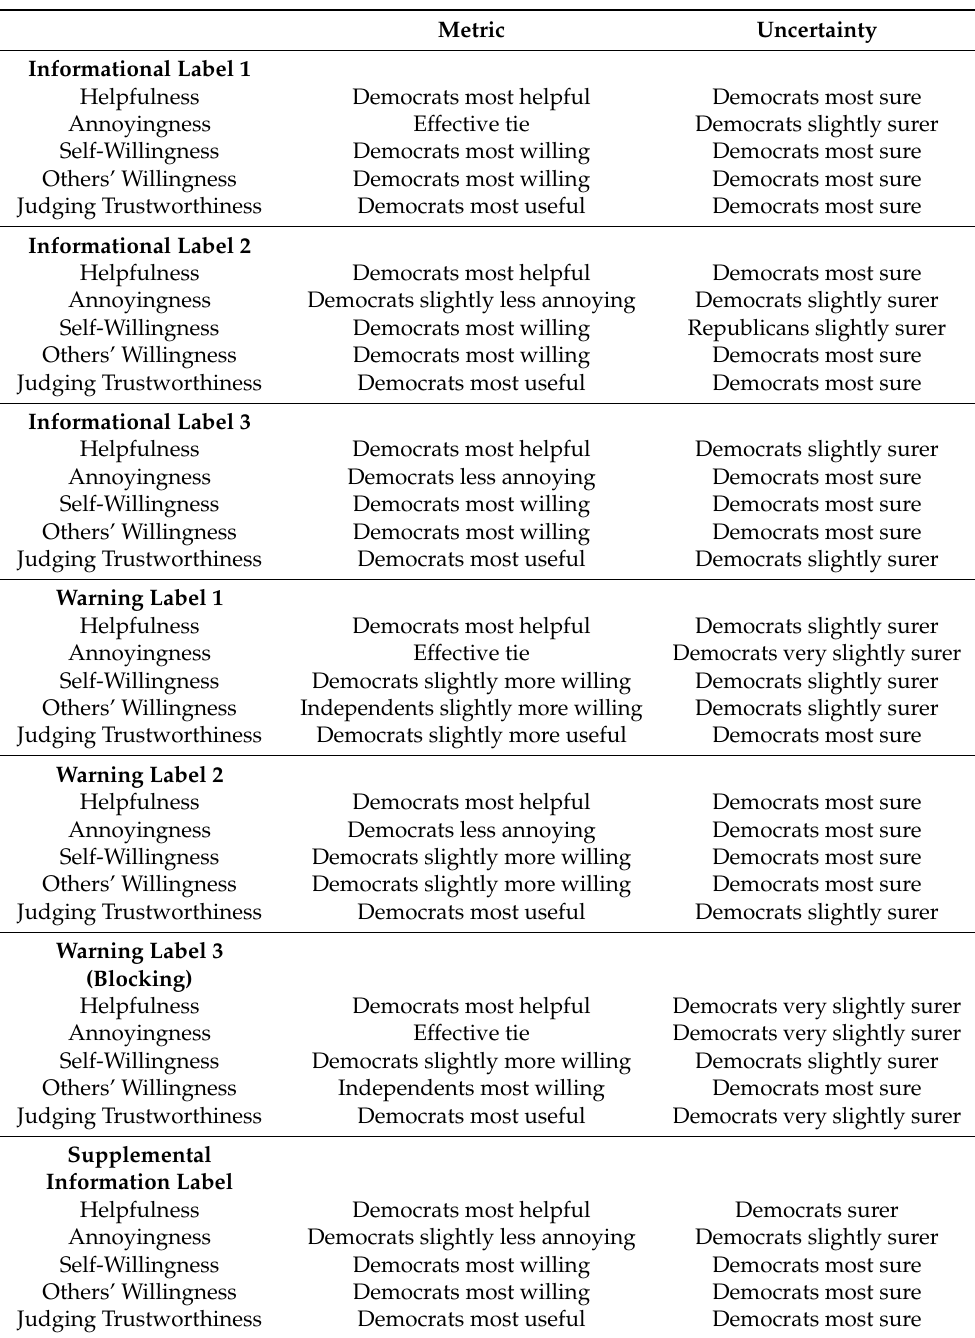
Table 2. Trends for label types for political affiliation